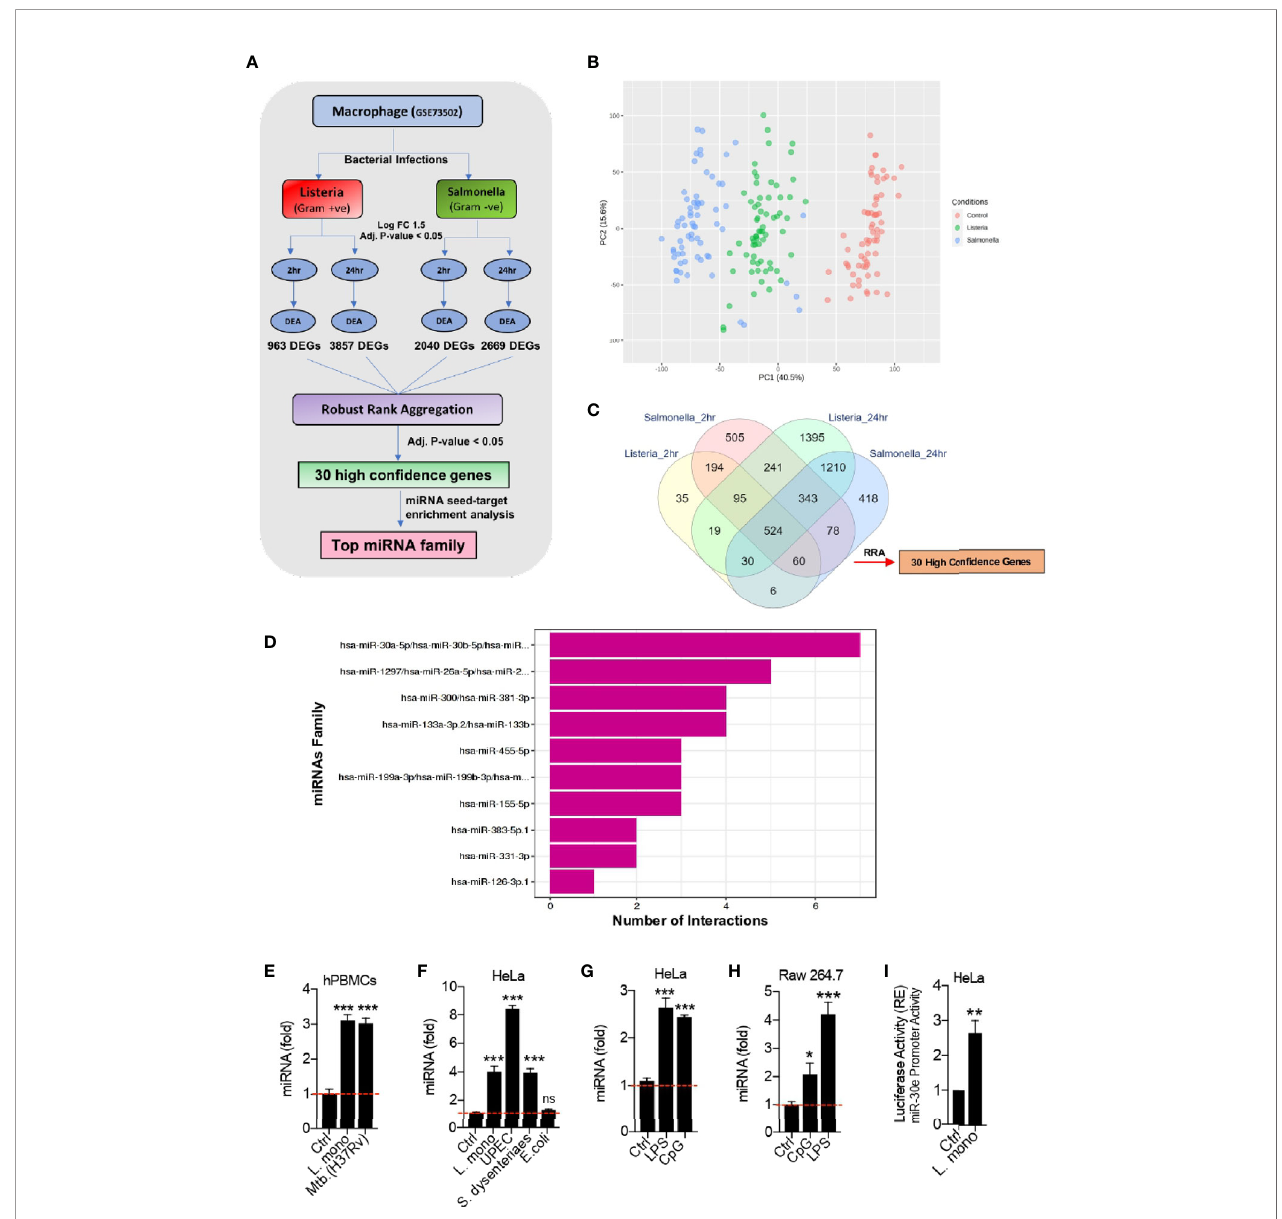
FIGURE 1 | Bioinformatic identi fi cation of crucial host genes and microRNAs (miRNAs) associated with bacterial infection in Macrophages. (A) Schematic of the bioinformatics pipeline used to identify the high con fi dence genes and the potential miRNAs that target them, upon infection with two different bacteria at different time points. (B) PCA plot shows the segregation of samples between three experimental groups – Control, Listeria and Salmonella infection. (C) Venn diagram shows the overlap of differentially expressed genes at 2 h and 24 h of Listeria and Salmonella infection compared to the corresponding uninfected samples giving 30 high con fi dence host factors obtained through robust rank aggregation (RRA) method. (D) Bar plot showing miRNA seed enrichment analysis for signi fi cant high con fi dence genes obtained through robust rank aggregation method. (E – H) Quanti fi cation (as determined by qRT-PCR analysis) of the fold changes in the abundances of miR-30e as indicated in hPBMCs, HeLa and Raw264.7 cells in presence of respective bacterial pathogens and PAMPs stimulation. (I) Quanti fi cation of miR-30e promoter activity by luciferase assay as indicated in HeLa cells. Data are mean +/- SEM of triplicate samples from single experiment and are representative of two independent experiments. *** P < 0.001, ** P < 0.01 and * P < 0.05 by one-way ANOVA Tukey test and student